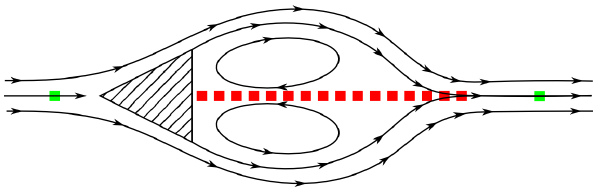
Figure 2. Schematic presentation of the array of microheaters (de- picted in red) and two additional temperature sensors (green).